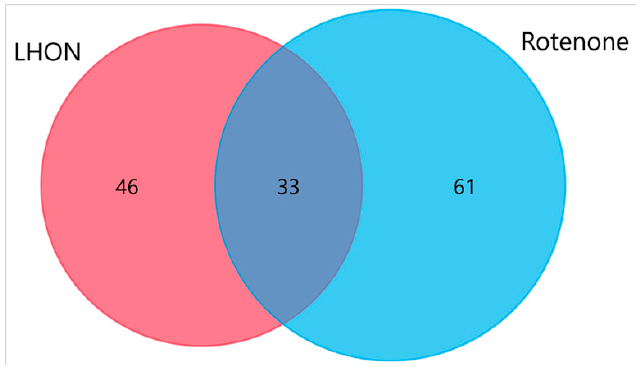
Figure 7. Venn diagram of elevated levels of glutathionylated proteins in LHON and Complex I-inhibited fibroblasts.